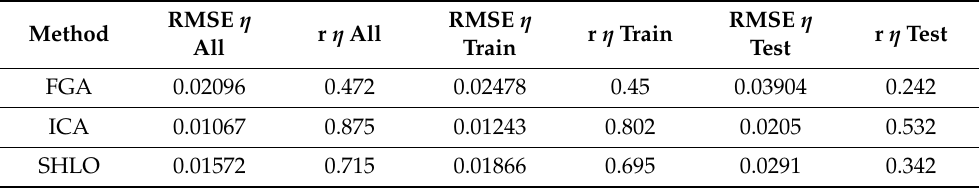
Table 3. RMSE and r metrics for the yield in the crosslinked polymer η , resulting from applying the tested algorithms for optimizing the neural network architecture and weights using the entire dataset (“all”), the training split (“train”), and subsequently testing on the test split (“test”). ICAHY is our